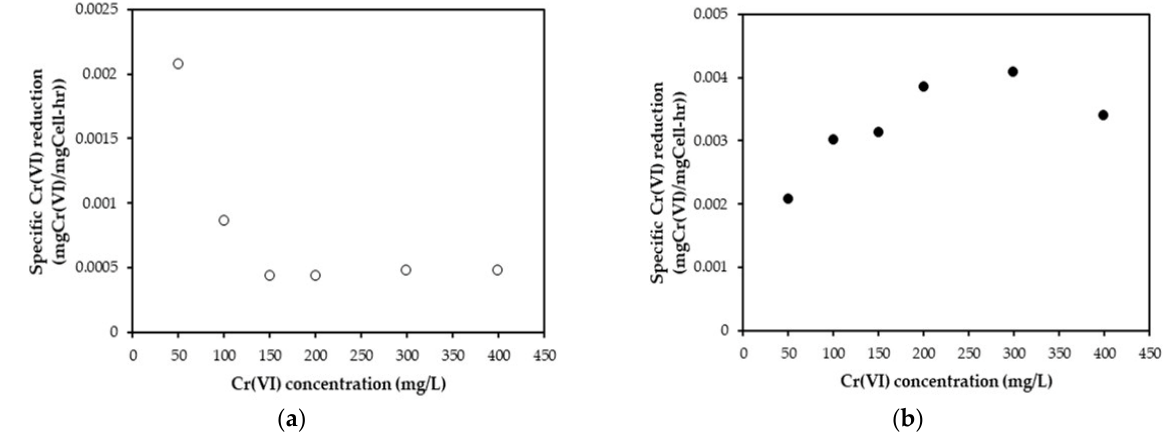
Figure 3. Specific Cr(VI) reduction at varying Cr(VI) concentration ( a ) after 5 h ( b ) after the duration of the experiment.